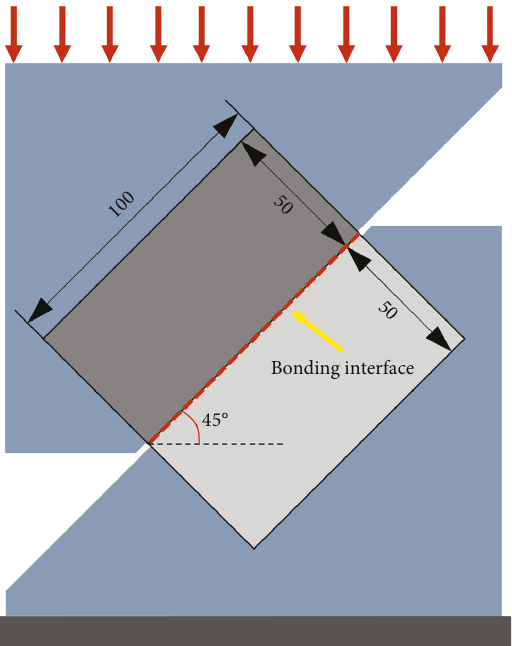
Figure 14: Bond oblique shear test loading diagram (unit: mm).